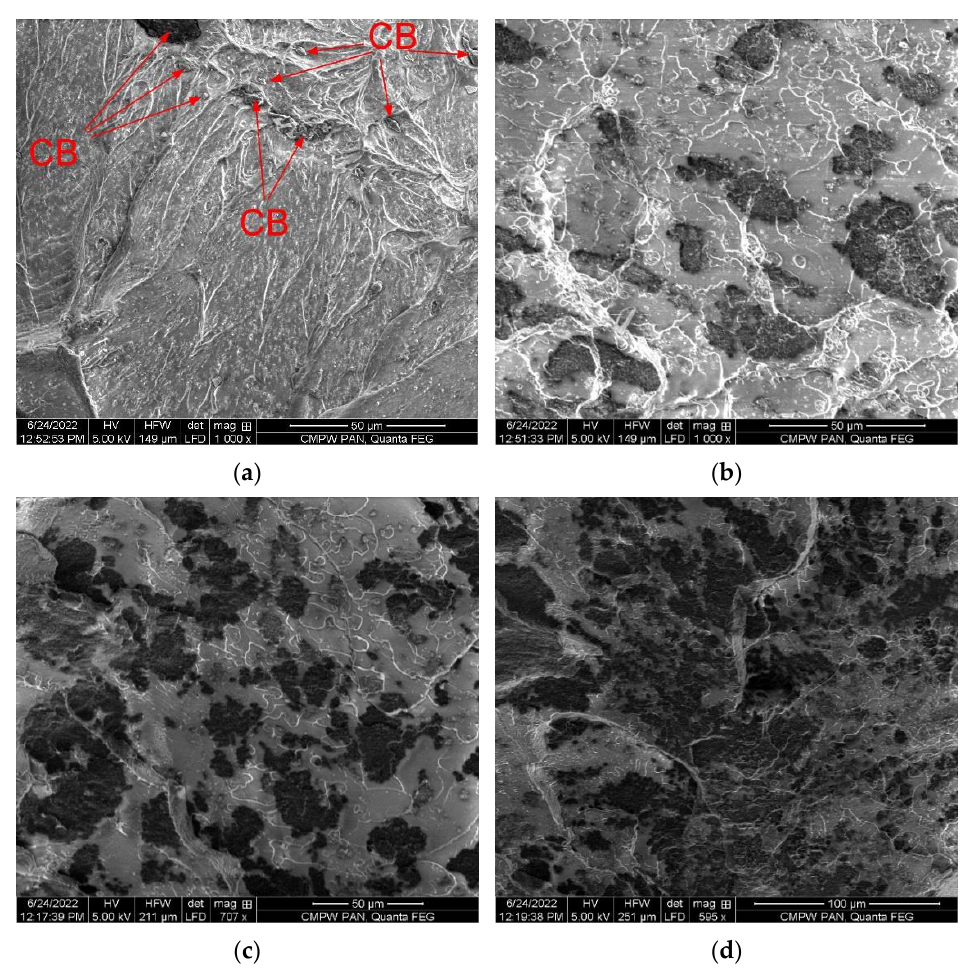
Figure 8. SEM images of the transverse cross-section of the specimen ’ s 3D printed with filaments: PLA + 1 vol.% CВ ( a ), PLA + 2.5 vol.% CВ ( b ), PLA + 5 vol.% CВ ( c ), PLA + 7 vol.% CВ ( d ). PLA + 1 vol.% CB ( a ), PLA + 2.5 vol.% CB ( b ), PLA + 5 vol.% CB ( c ), PLA + 7 vol.% CB ( d